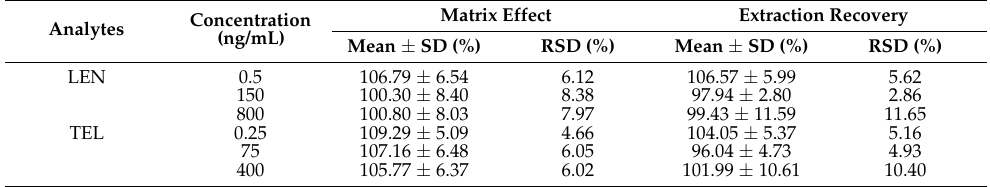
Table 2. Matrix effect and extraction recovery of LEN and TEL in rat plasma ( n = 6).